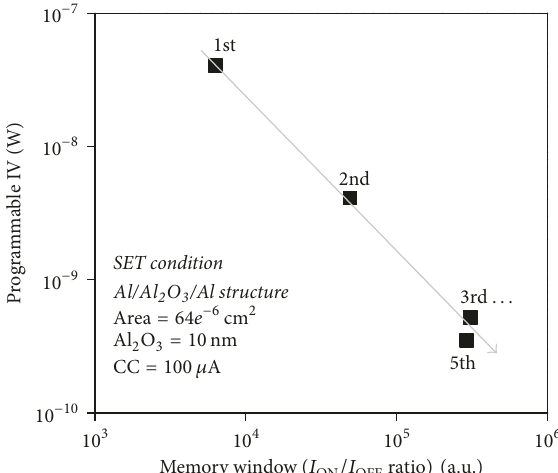
Figure 8: Based on the data of Figure 6(b), the power needed to promote continuous resistive switching of that MIM structure is reduced, while the memory window ( 𝐼 ON /𝐼 OFF ratios) increases. Even though these are desirable characteristics for a ReRAM device, this behavior is a consequence of the progressive reduction in the 𝑉 SET parameter which, in turn, will compromise endurance and the general reliability of these memory devices.